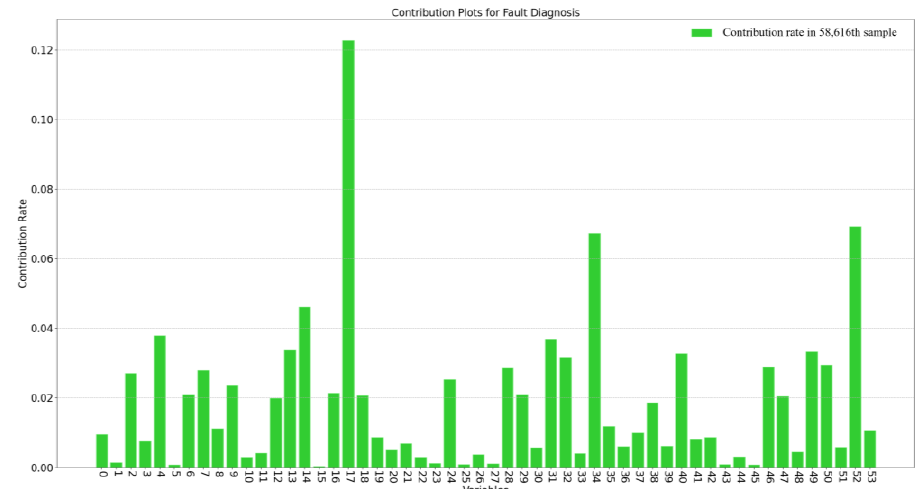
Figure 11. Contribution plots calculated in 58,616th sample.